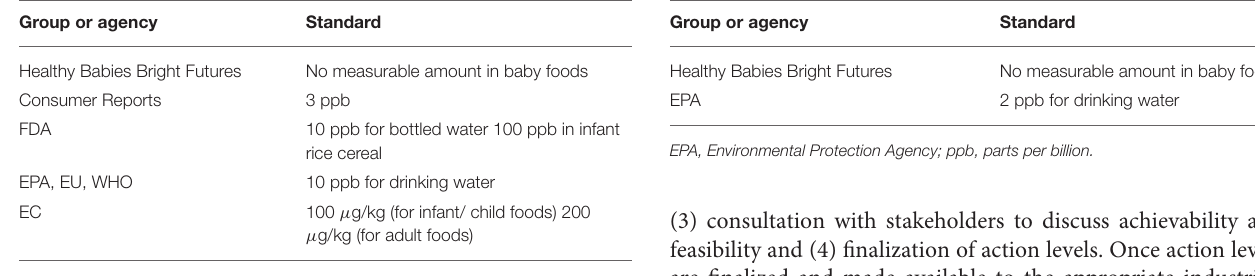
TABLE 5 | Proposed and existing mercury